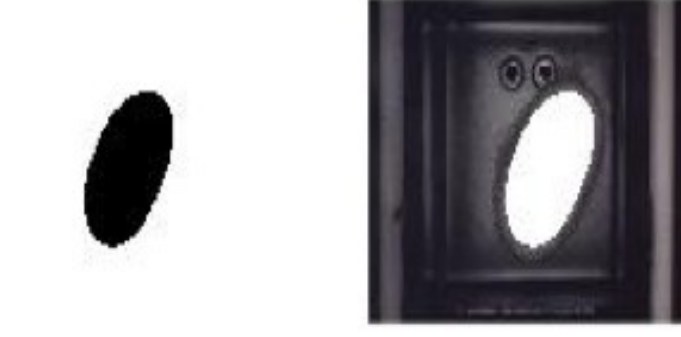
Figure 3. Result of the cocoon segmentation procedure. From left to right: image of cocoons, segmented image and superimposition of the segmented cocoon outline with the original